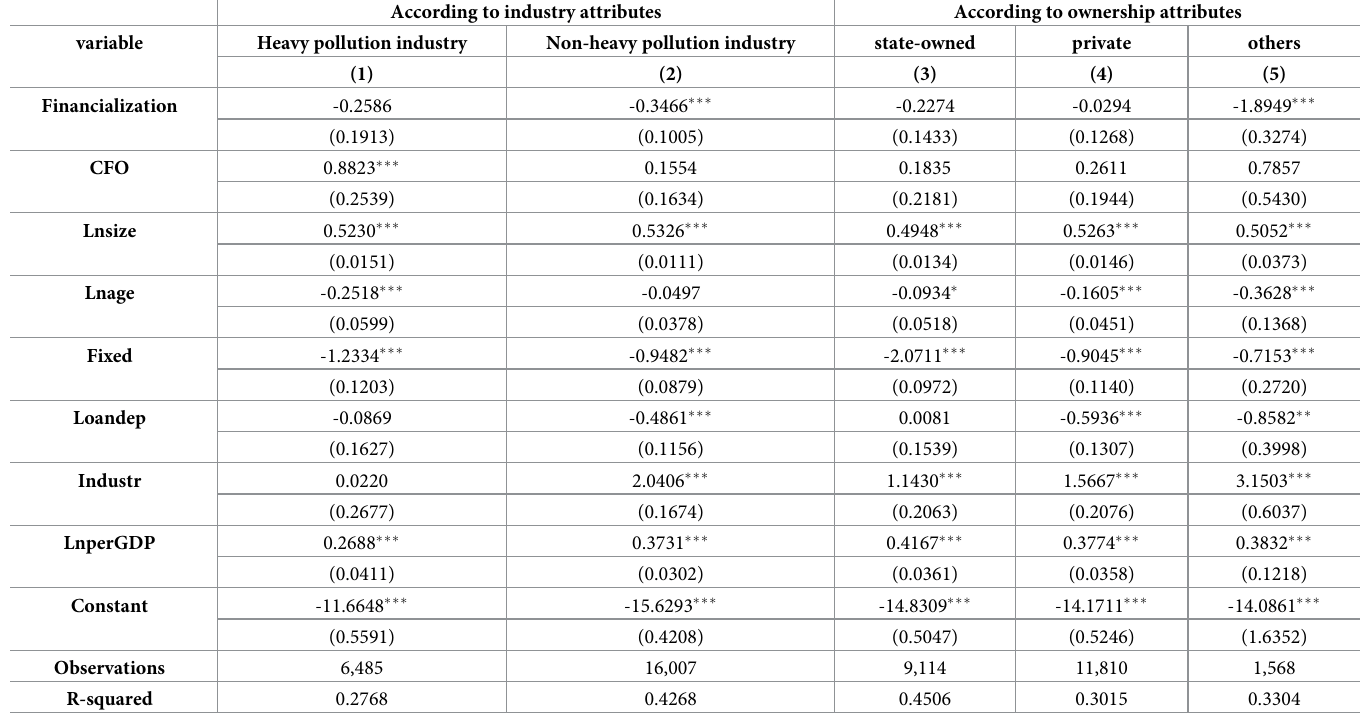
Table 6. Test results of the impact of enterprise financialization on technological innovation based on enterprise